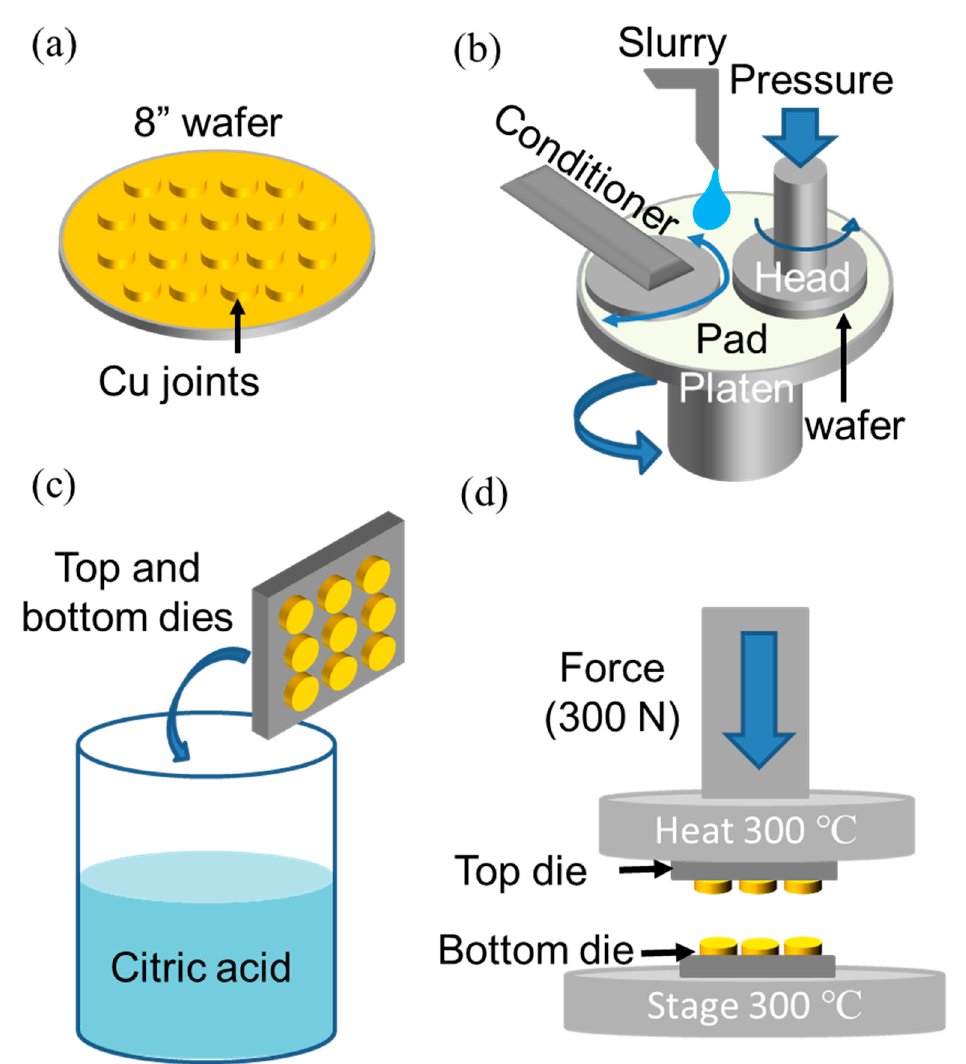
Figure 2. Schematic diagram of the Cu joint fabrication: ( a ) the DC electrodeposition, ( b ) CMP, ( c ) cleaning, and ( d ) bonding processes of the Cu joints.